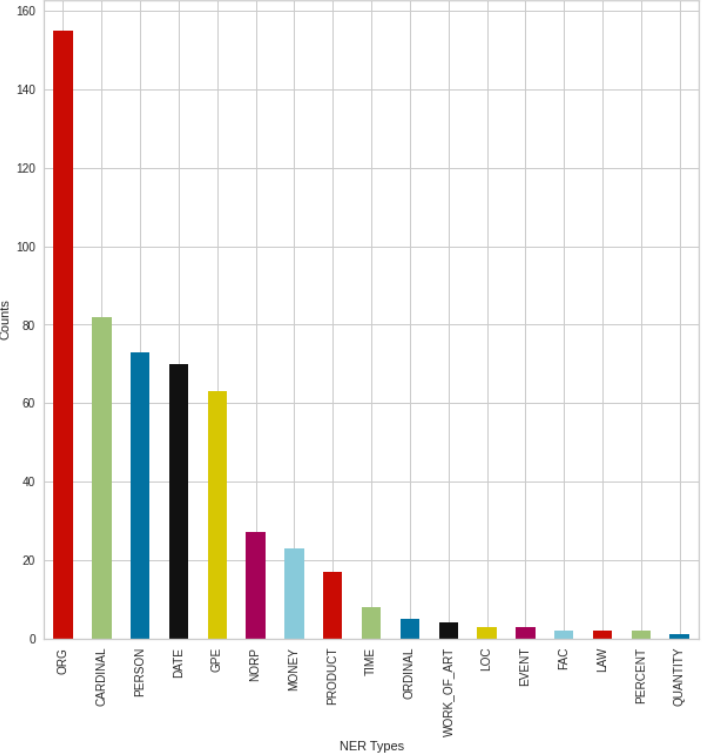
Figure 19. NER types of the positive tweets. The time period stands between 2 September 2021 and 4 September